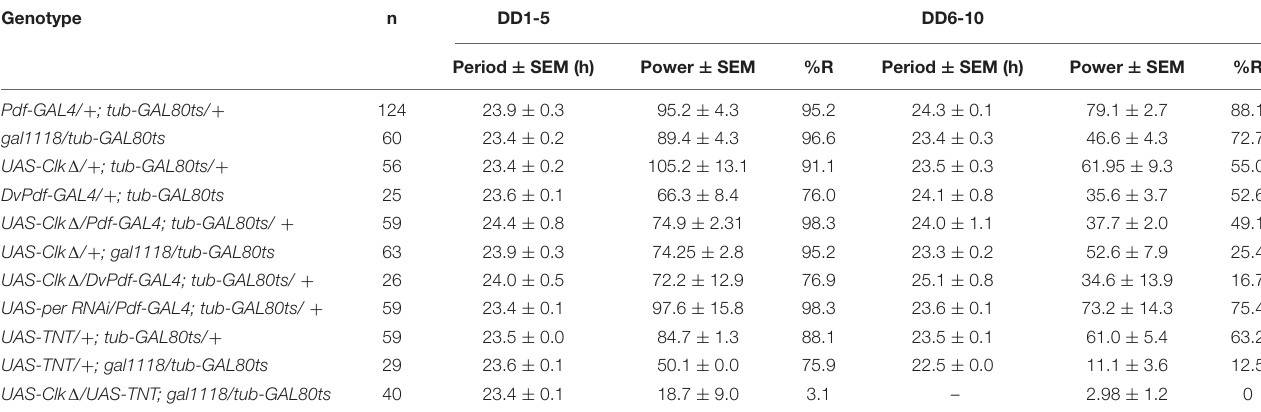
TABLE 1 | Free-running locomotor rhythms in flies with adult-restricted genetic manipulations. Genotype